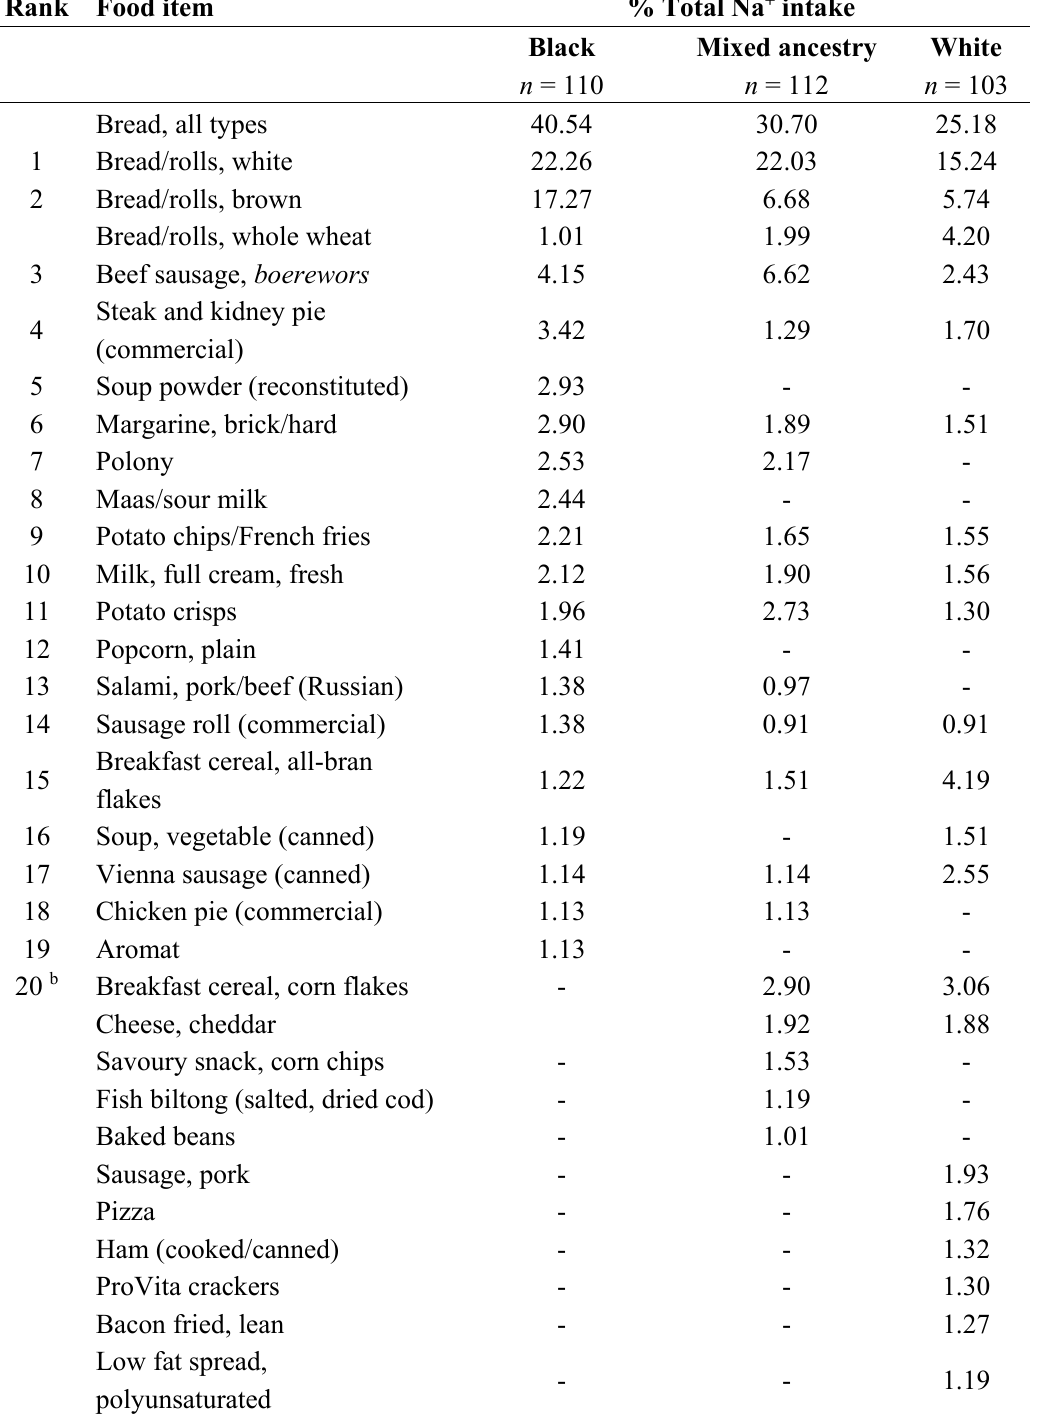
Table 1. Contribution of top 20 individual food items to total non-discretionary sodium intake a , in a multi-ethnic sample in Cape Town, South Africa (this table is redrawn from Charlton, et al ., 2005 [56]. Copyright 2005, with permission from Elsevier